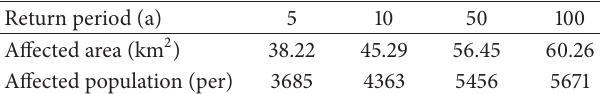
Table 9: The table of population affected by